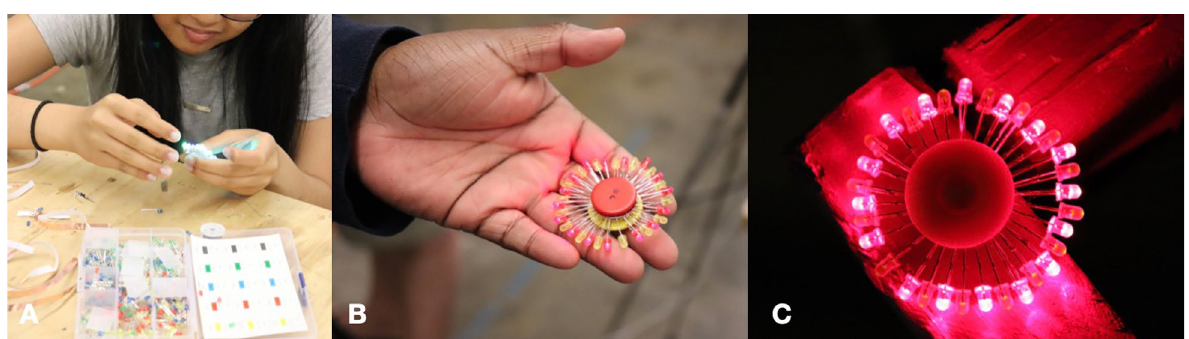
Fig. 3 A Luanne explores different configurations and variations of the LEDs; B LEDs arranged around a coin‑cell battery; C the circular LED array that came from playing with different configurations of LEDs (Photos: